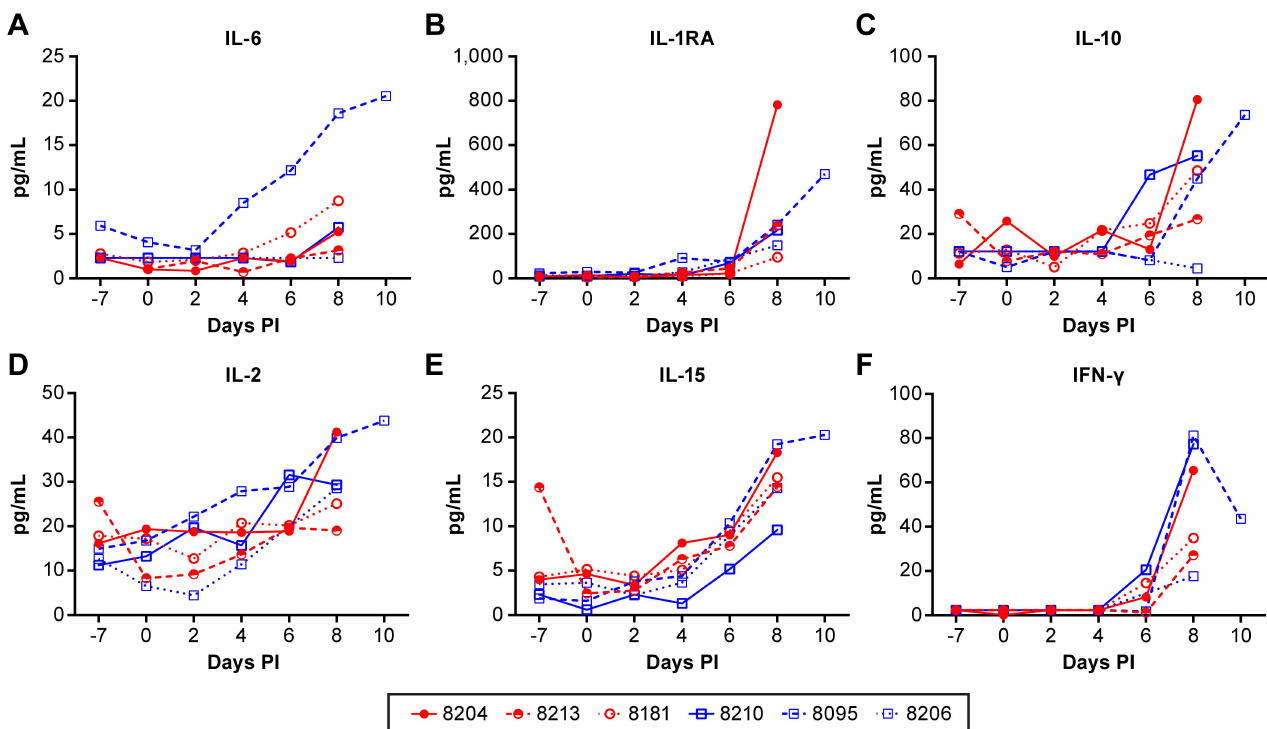
Fig 7. Evaluation of cytokine levels in serum collected from NiV infected AGM over the course of disease. Cytokines associated with inflammation (IL-6, IL-1RA, IL-10) (panels A-C) and Th1 immunity (IL-2, IL-15, IFN- γ ) (panels D-F) increasein the serum with diseaseprogressionin most animalsinfected with NiV by IT (black) or aerosol (gray) inoculation.These data demonstrate the presenceof a systemic inflammatory responseand suggest the onset of a cell-mediated immune response.